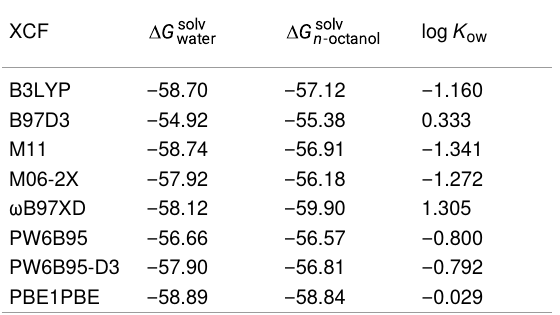
Table 2: Calculated solvation free energies in water ( ), in 1-octanol ( ) and corresponding partition coefficient log K ow for BTD-4APTEG. Solvent effects included with the SMD solvation